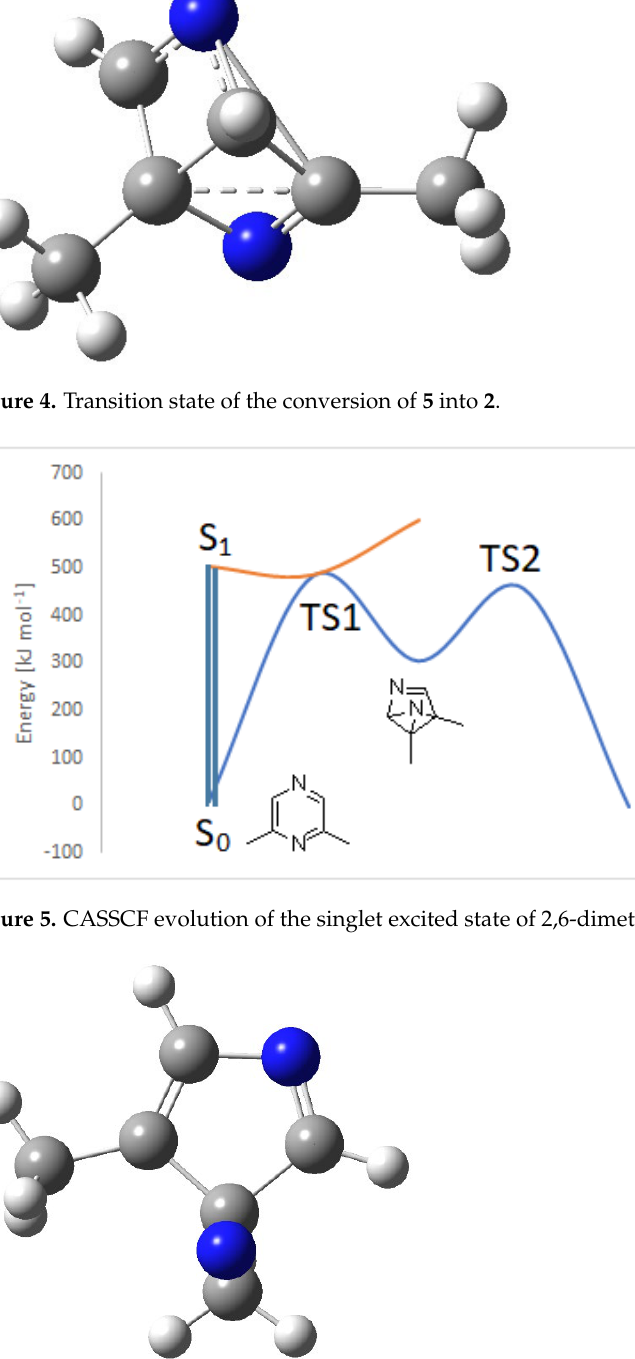
Figure 6. Structure of 2,6-dimethylpyrazine at the conical intersection.